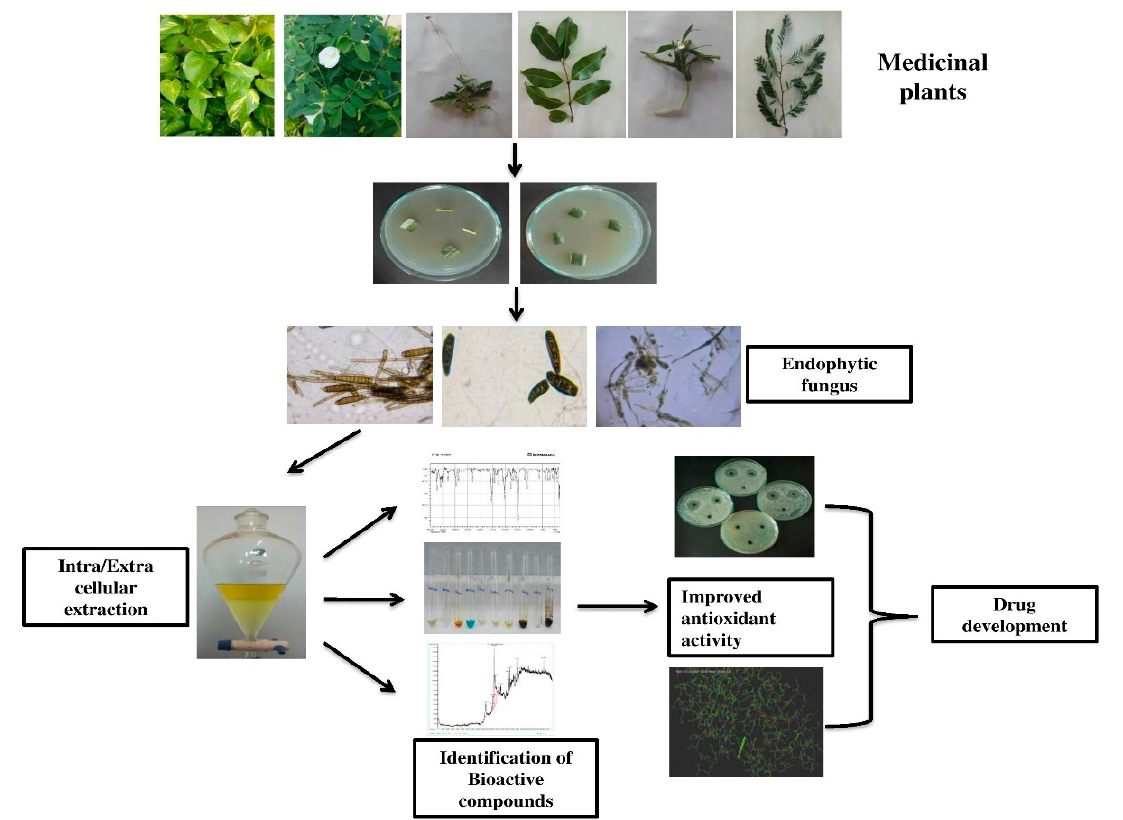
Figure 1. A schematic representation of the workflow of the current